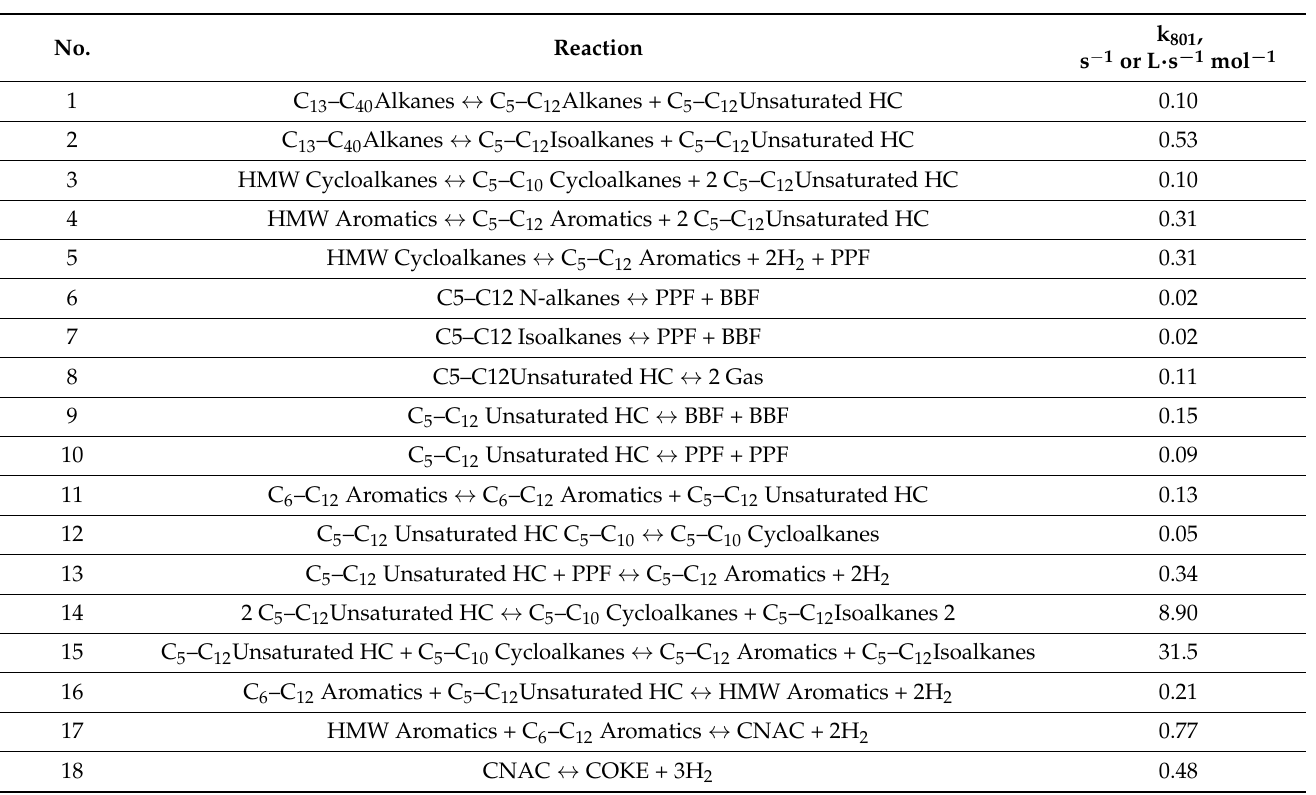
Table 4. The kinetic patterns of catalytic